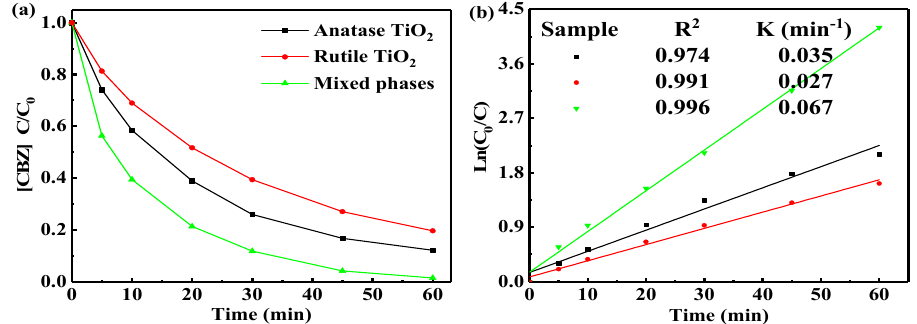
Figure 5. ( a ) Degradation of CBZ by UV-LED/TiO 2 using different crystal forms of nano-TiO 2 photocatalyst. ( b ) The pseudo-first-order kinetic models of CBZ degradation by UV-LED/TiO 2 using different crystal forms of nano-TiO 2 photocatalyst . C(CBZ) 0 = 18.8 µM; operating temperature = 20 °C; wavelength of UV-LED = 365 nm; operating pH = 7.6; and C (mixed-phase TiO 2 ) = 2.0 g/L.